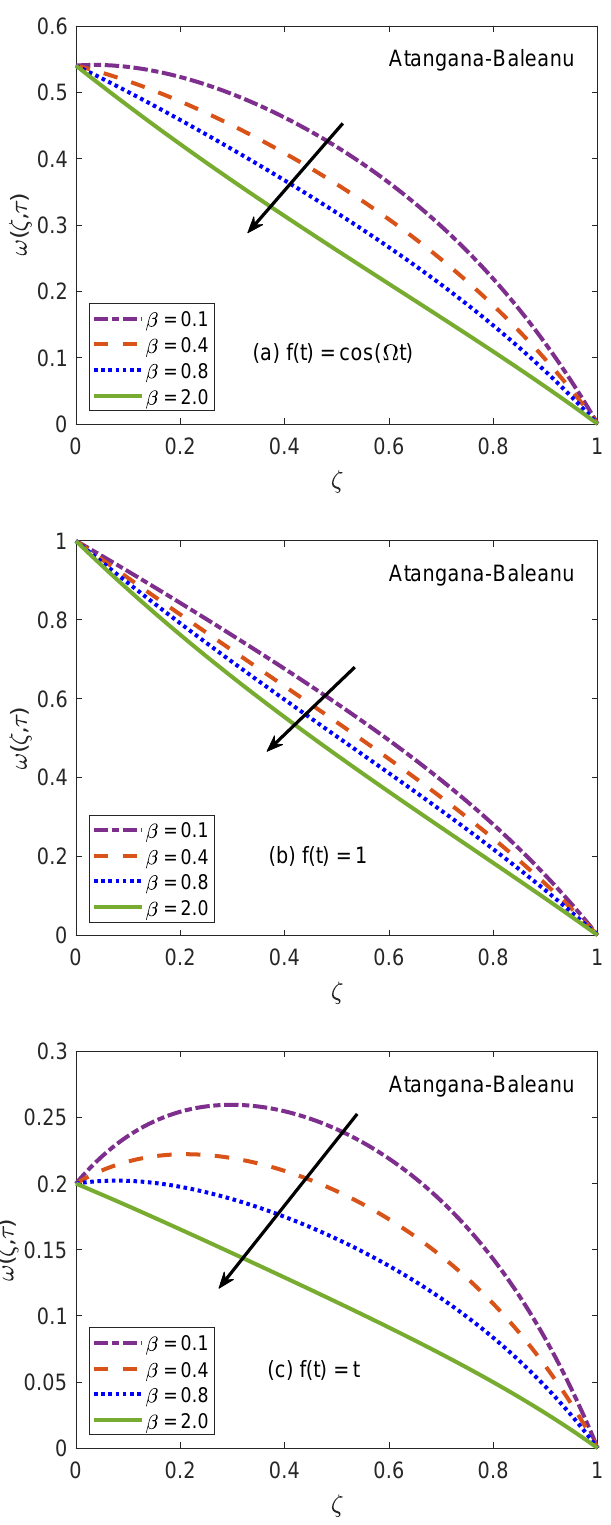
Figure 10. Velocity patterns for variation of β